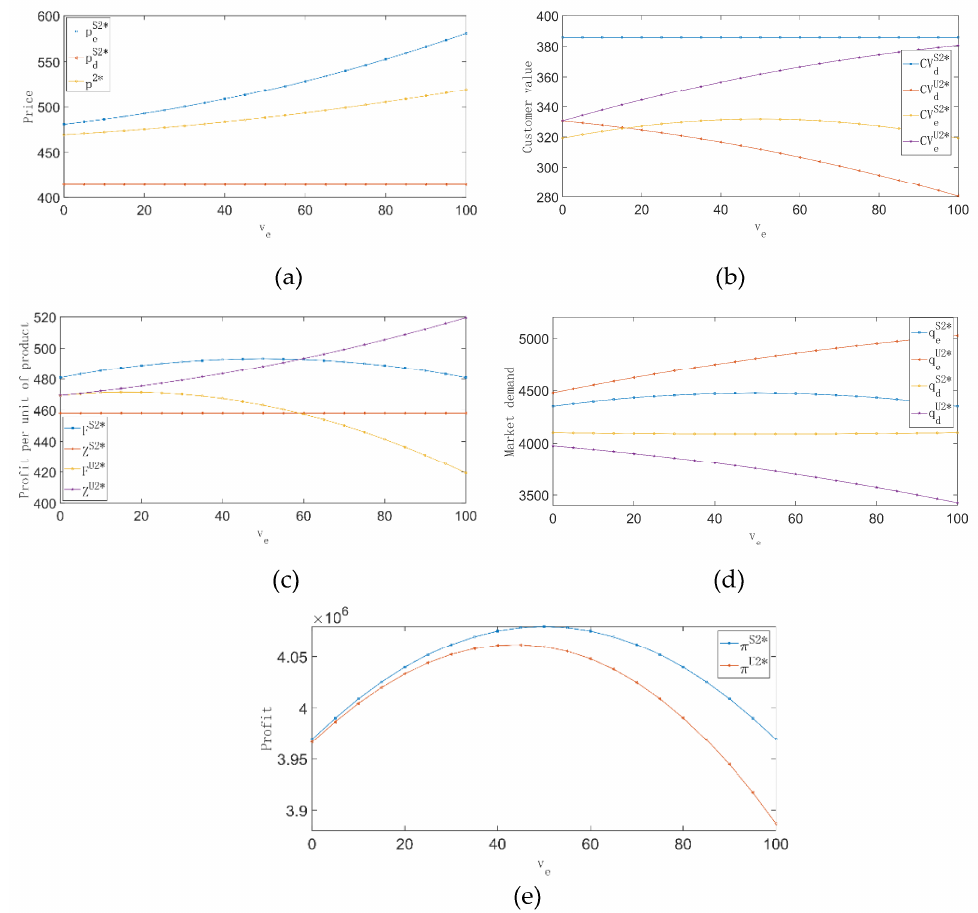
Figure 3. The impact of value-added services value on equilibrium results under centralized decision- making. ( a ) The impact of e on sales price. ( b ) The impact of e on customer value. ( c )The impact of e on unit product profit. ( d ) The impact of e on market demand. ( e ) The impact of e on total profit of supply chain.